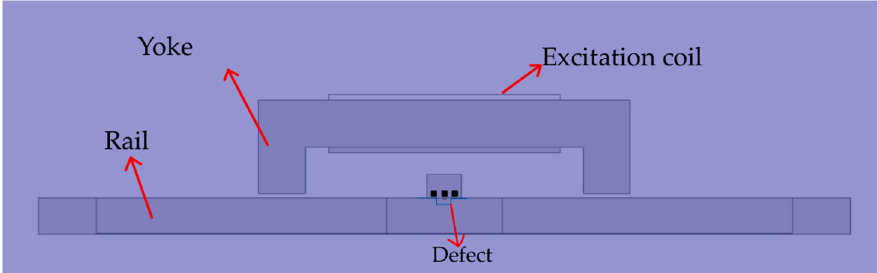
Figure 4. Simulation Model.